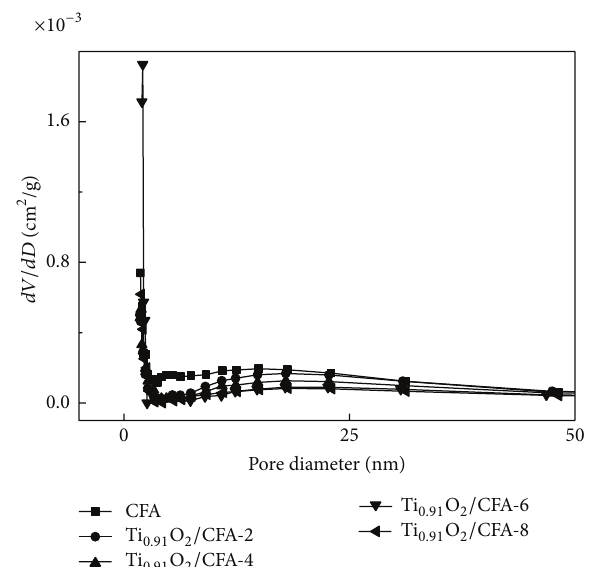
Figure 6: Pore size distributions of CFA and Ti 0.91 O 2 /CFA.